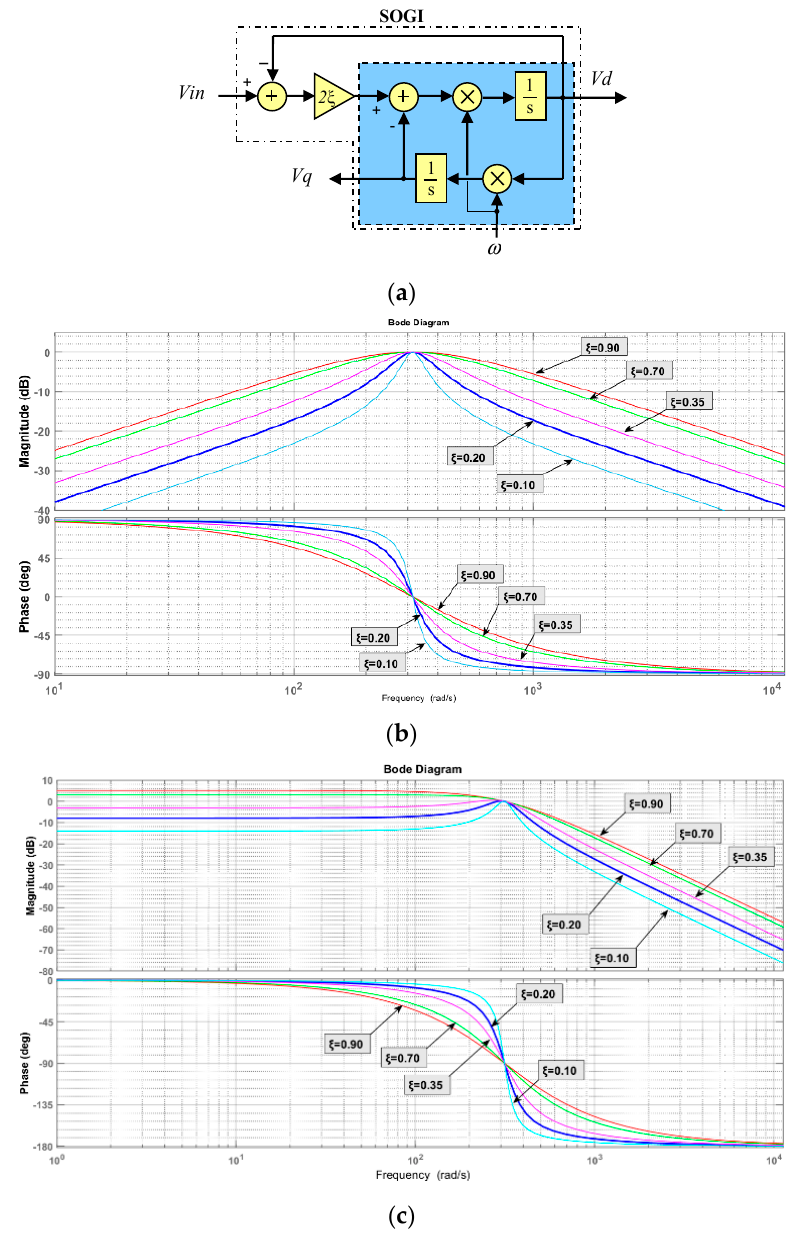
Figure 4. Structure of second-order generalized integrator (SOGI) and bode diagrams with various damping factors: ( a ) structure of a SOGI with its damping factor, ξ , and center frequency, ω , where V in is the input signal, V d the direct output signal, filtered by a band-pass filter (BPF); V q the in-quadrature output signal, filtered by a low-pass filter (LPF). ( b ) Magnitude and phase Bode plots for BPF in (13), varying ξ from 0.1 to 0.9. ( c ) The magnitude and phase Bode plots for LPF in (14) varying ξ from 0.1 to 0.9.